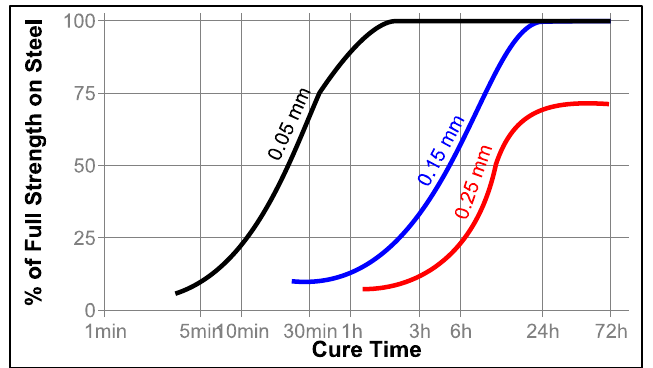
Figure 5. Cure speed of adhesive versus bond gap [13].